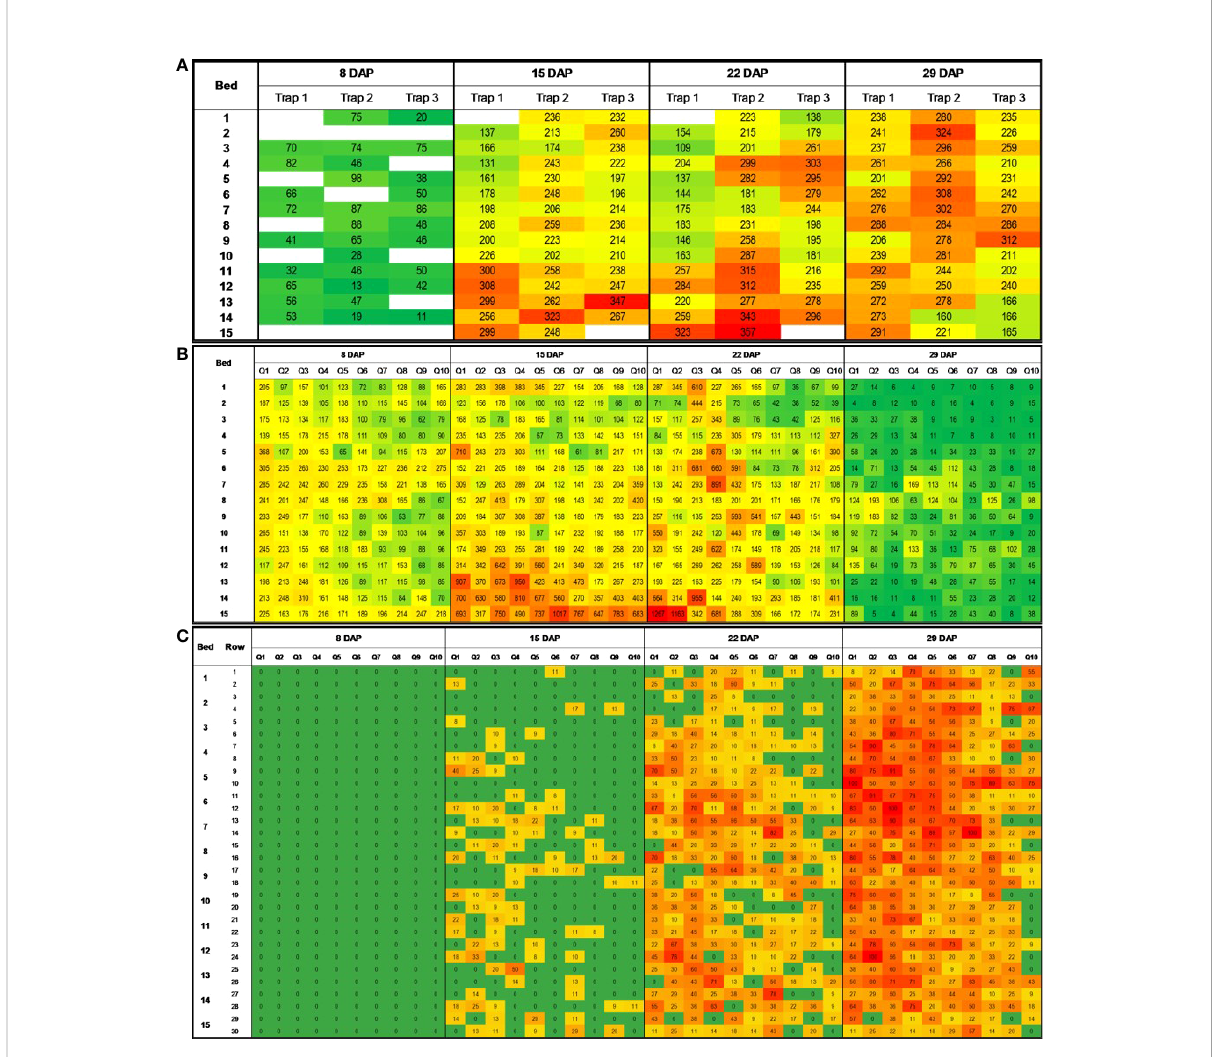
FIGURE 3 Heatmaps showing number of adult white fl ies a per 2cm² sticky trap (A) , number of adult white fl ies in leaves (B) , and WTVC incidence b (C) over time and space in the experimental fi eld at the UGA Black Shank Farm in 2019. a Average number of adult white fl ies in eight 2cm 2 areas of a sticky trap (four in each side, front and back); b percent incidence of WTVC infected plants per 3.05m long rows of squash. Green areas had lower numbers of white fl ies and lower WTVC incidence. Red areas had higher white fl y counts and WTVC